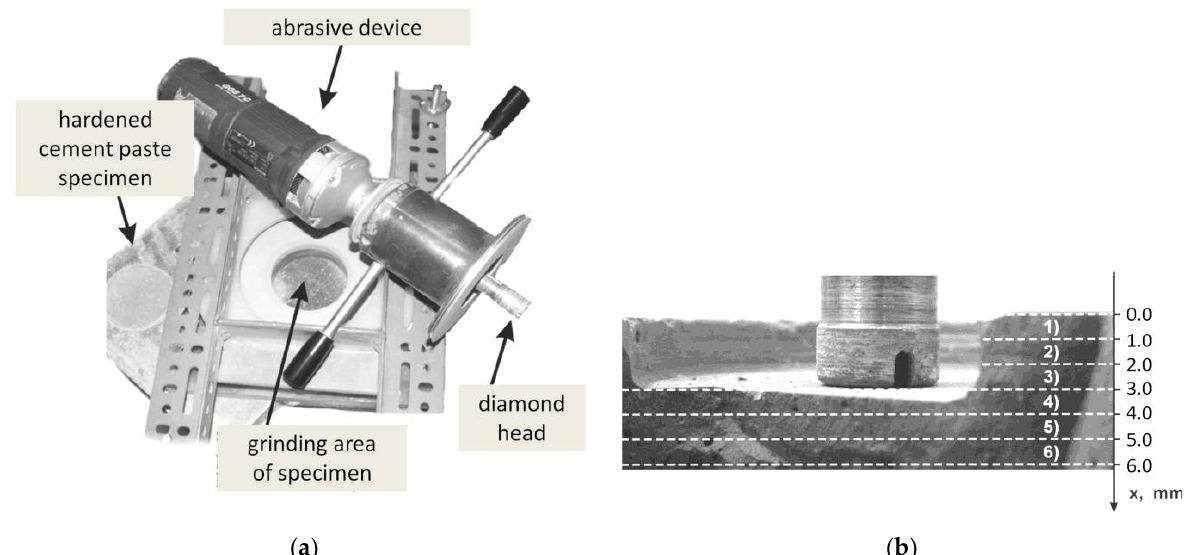
Figure 2. Sampling of powdered samples: ( a ) Workplace with abrasive device; ( b ) Diamond head and exemplary layering.